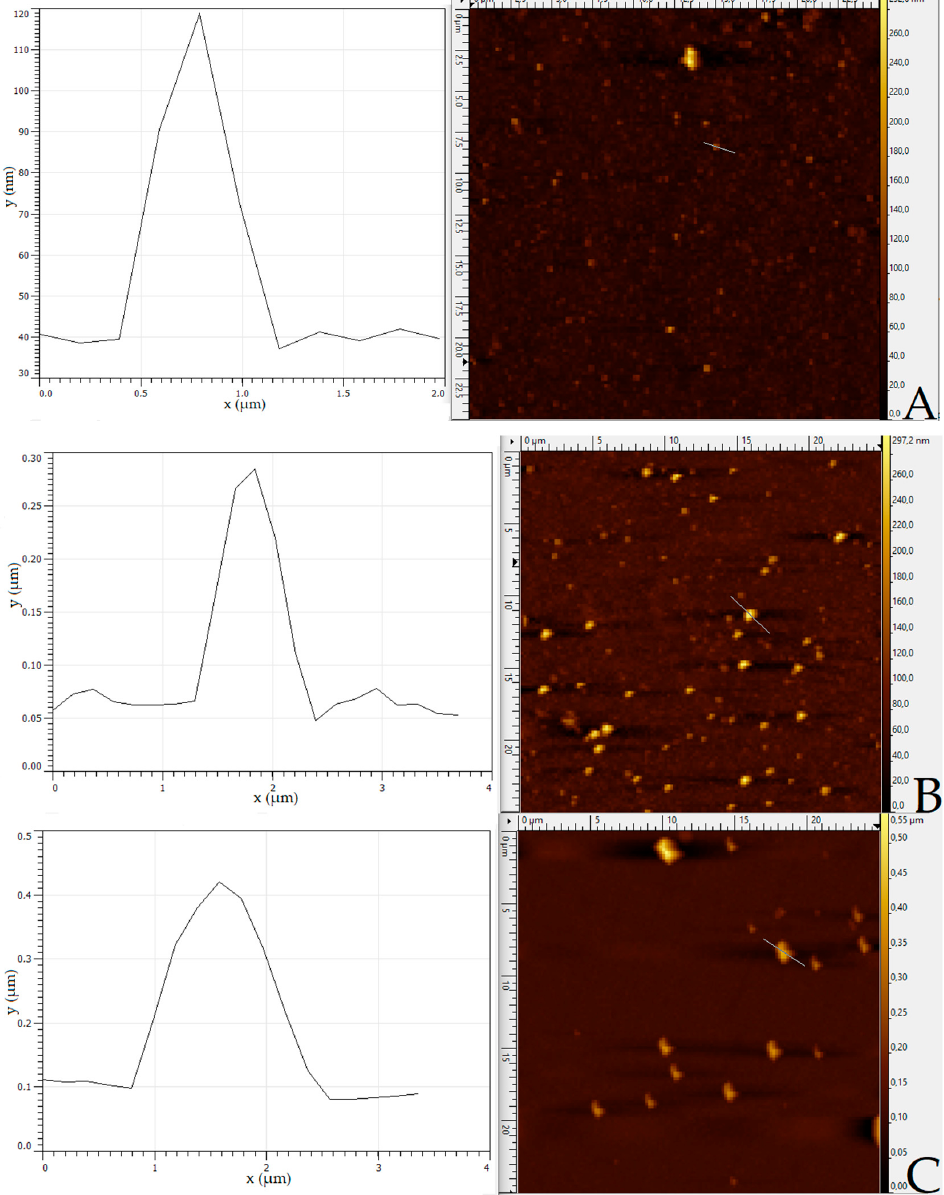
Figure 5. AFM image of particles created with ( A ) 0.01 wt% PCL, ( B ) 0.1 wt% PCL, and ( C ) 1 wt% PCL in the organic phase. The height image (left column) shows the diameter and height of representative particles.